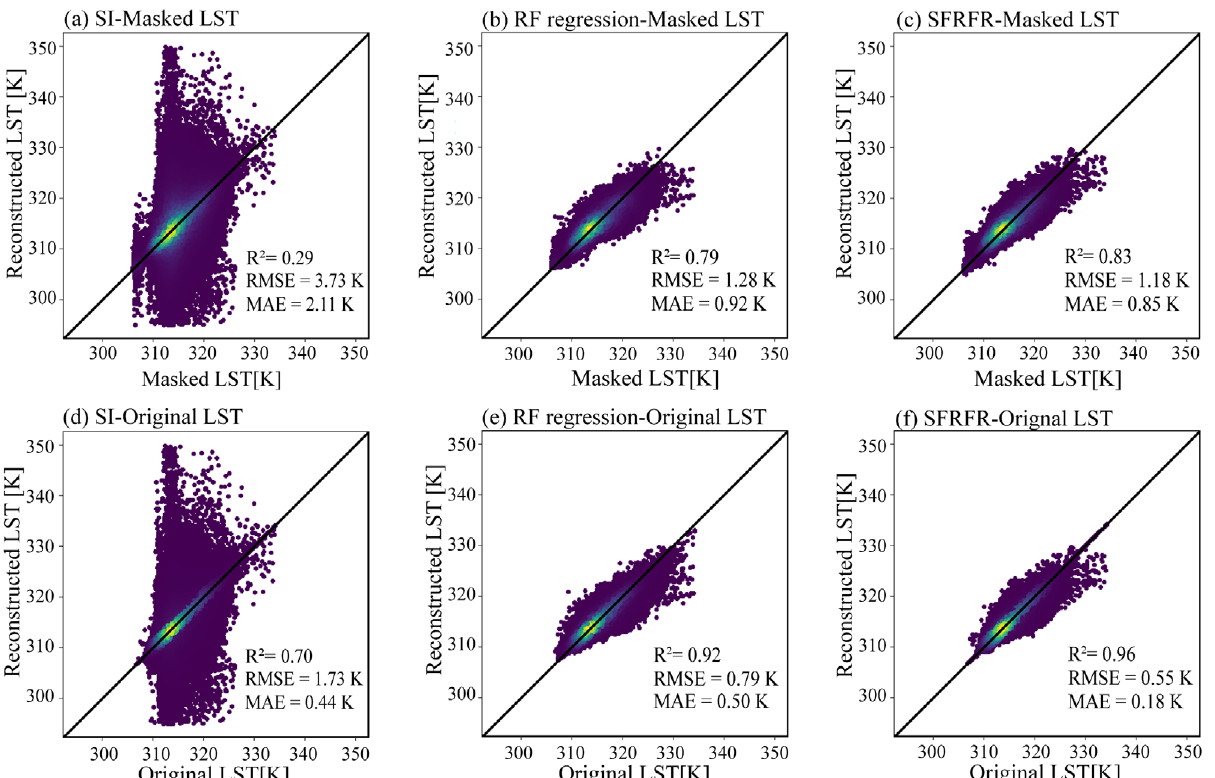
Figure 4. Scatter density plots between the LST predicted by the three methods and the observed LST: ( a – c ) LST plots constructed by the SI, RF regression, and SFRFR models against the masked LST; ( d – f ) LST plots constructed by the SI, RF regression, and SFRFR models against the original LST.